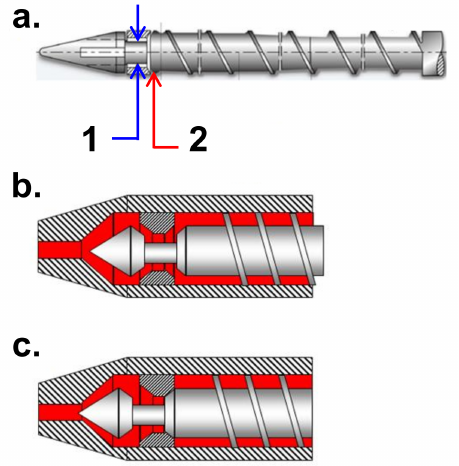
Figure 13. ( a ) IM screw features: (1) diameter of the restriction of the injection chamber and valve (2); features (1) and (2) positions during ( b ) feeding and ( c ) injection. Reproduced with permission from